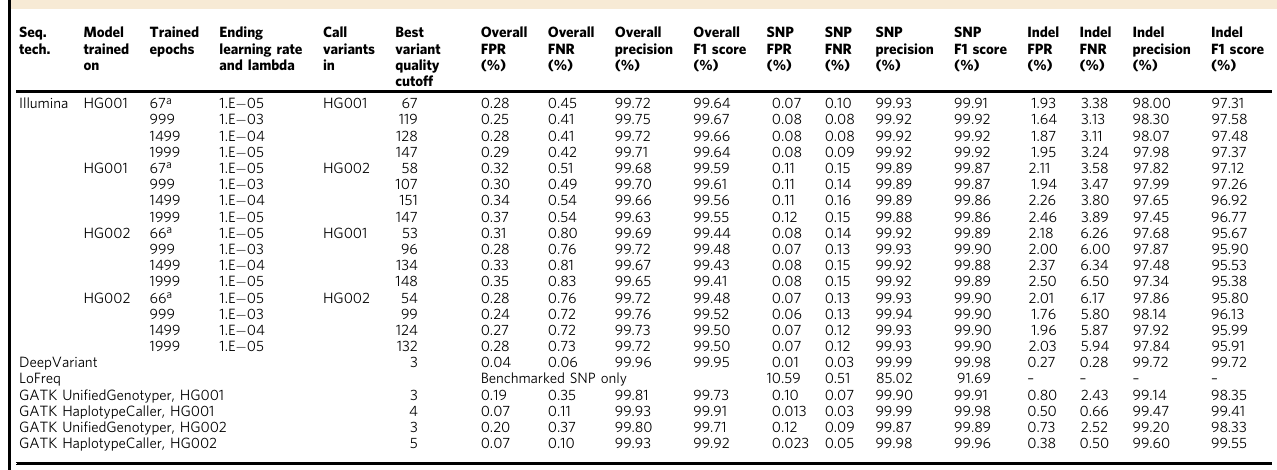
Table 2 Performance of Clairvoyante on Illumina data at common variant sites in 1KGp3 Seq.